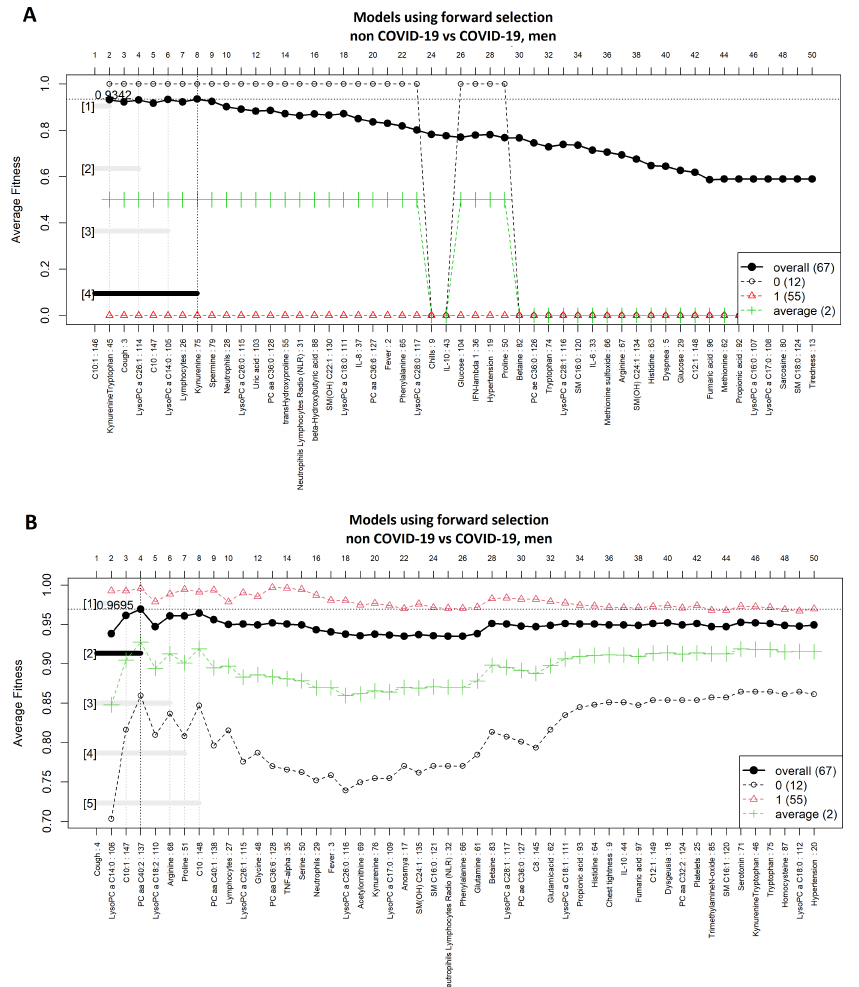
Figure 9. Forward selection model construction for classification of men with COVID-19 vs. men without COVID-19. ( A ) logistic regression and ( B ) support vector machine models. The vertical axis shows the classification accuracy. The solid line represents the overall accuracy calculated by measuring the misclassified samples divided by the total number of samples. The colored dashed lines represent the accuracy per class [36]. The logistic regression function was computed using an external implementation coupled to the GALGO library; therefore, the dashed/average lines for this model could not be